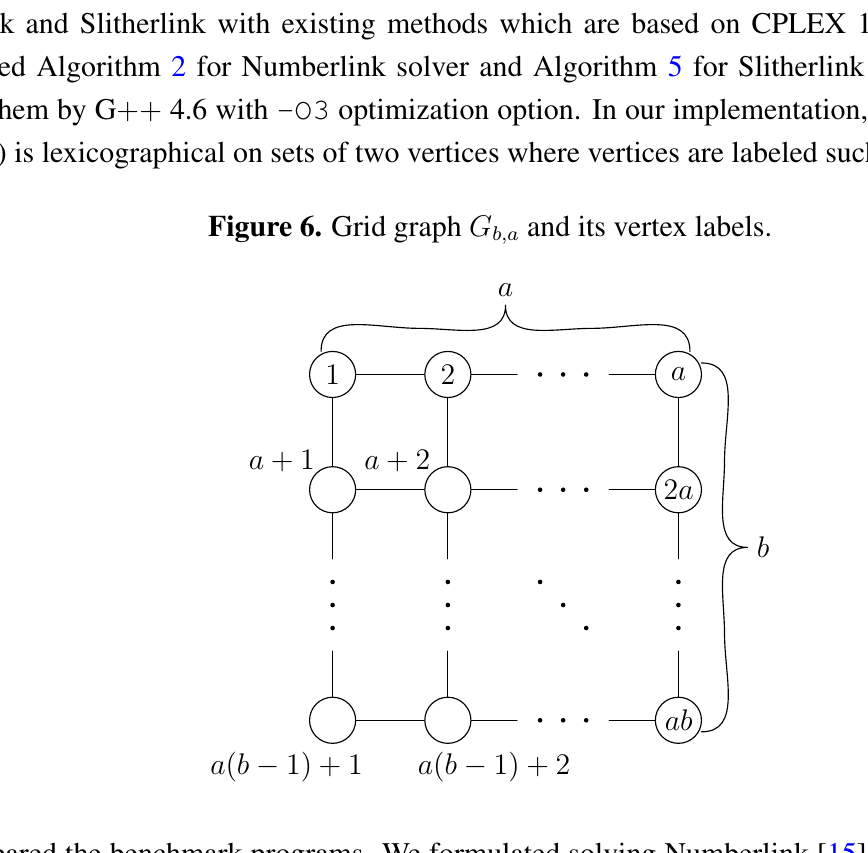
Figure 6. Grid graph G